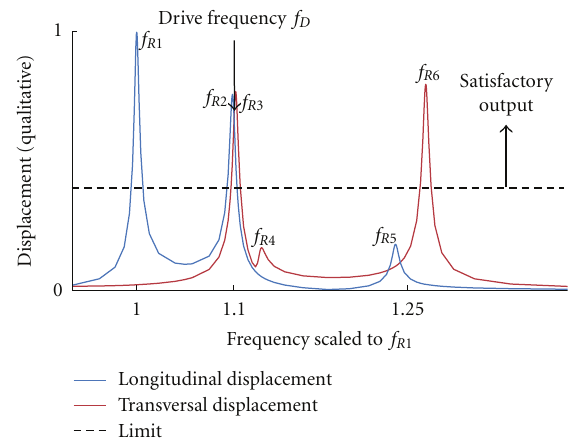
Figure 15: Amplitude response of the redesigned